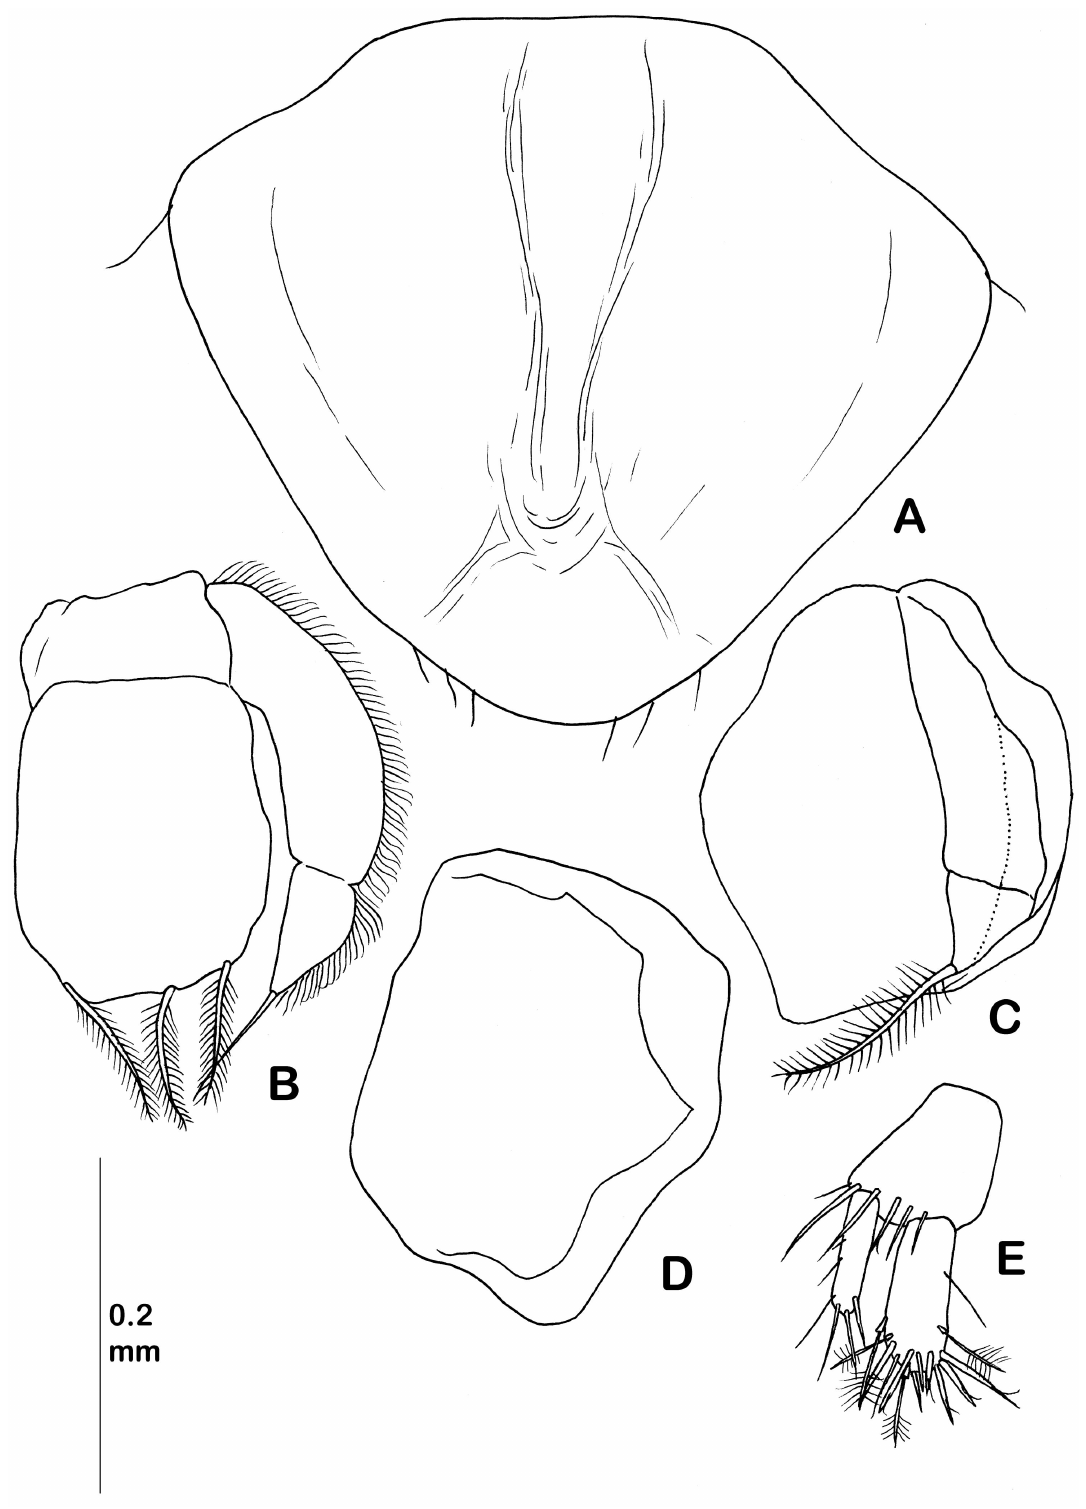
Figure 37. Eurycope mathiasi sp. nov. Female paratype (ZMH K-45662): ( A ) pleopod II; ( B ) pleopod III; ( C ) pleopod IV; ( D ) pleopod V; ( E ) uropod. Pleopod III (female paratype, ZMH K-45662, Figure 37B) protopod length 0.5 times width; endopod length 1.25 times width; three distal plumose setae length 0.4 times pleopod III length; exopod reaching slightly behind endopod distal margin, 0.4 times as wide